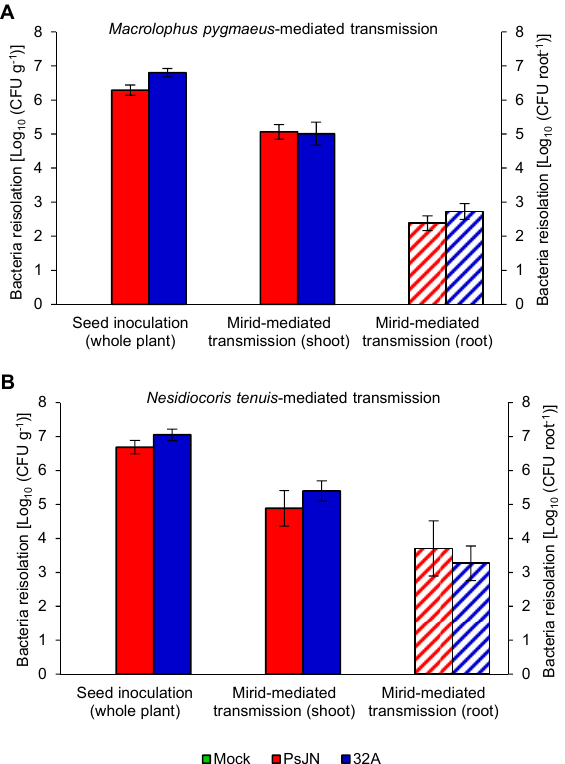
Figure 3. Quantification of endophytic bacterial strains in tomato plants. Bacterial re-isolation was carried out from seed-inoculated whole plants at the end of the acquisition period (Day 11) and from shoots or roots of plants at the end of the mirid-mediated transmission (Day 14) with Macrolophus pygmaeus ( A ) or Nesidiocoris tenuis ( B ). The quantity of re-isolated bacteria are expressed as colony forming units (CFU) per gram of fresh weight of the whole plant (CFU g − 1 ) and plant shoot (CFU g − 1 ), or as CFU for each plant root (CFU root − 1 ) of mock-inoculated plants (Mock, green) and plants inoculated with Paraburkholderia phytofirmans PsJN (PsJN, red) or Enterobacter sp. 32A (32A, blue). The two-way analysis of variance showed no significant differences between the two experimental repetitions ( p > 0.05) and data from the two experiments were pooled. Mean and standard error values for positive samples and at least nine replicates (plants) are presented for each treatment. For each treatment, no significant differences were found in the pairwise comparisons between PsJN- and 32A-inoculated samples, according to the Mann–Whitney test ( p ≤ 0.05). Neither PsJN nor 32A bacterial colonies were isolated from the mock-inoculated